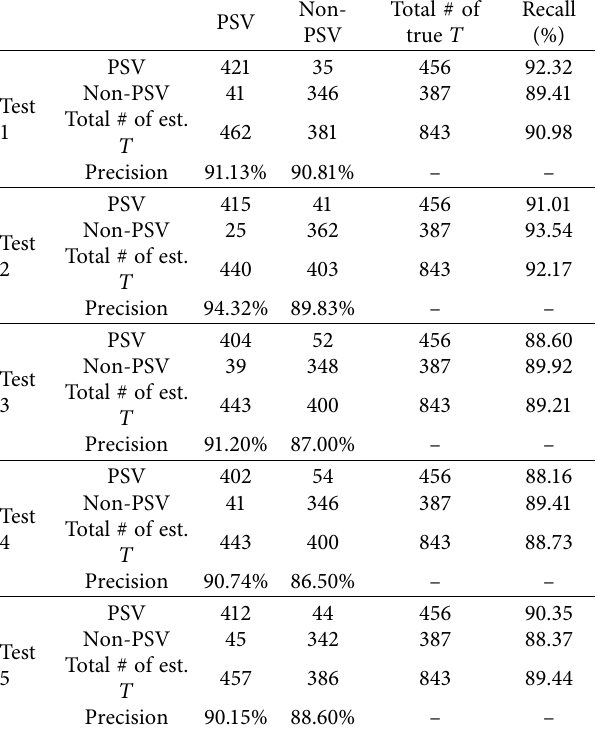
Table 2: Classification